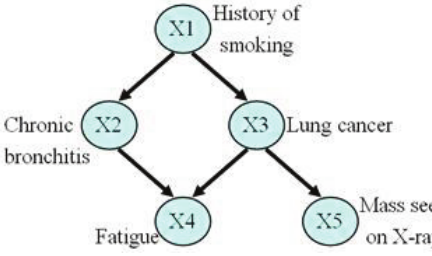
Fig. 3 Bayesian Network (Cooper,